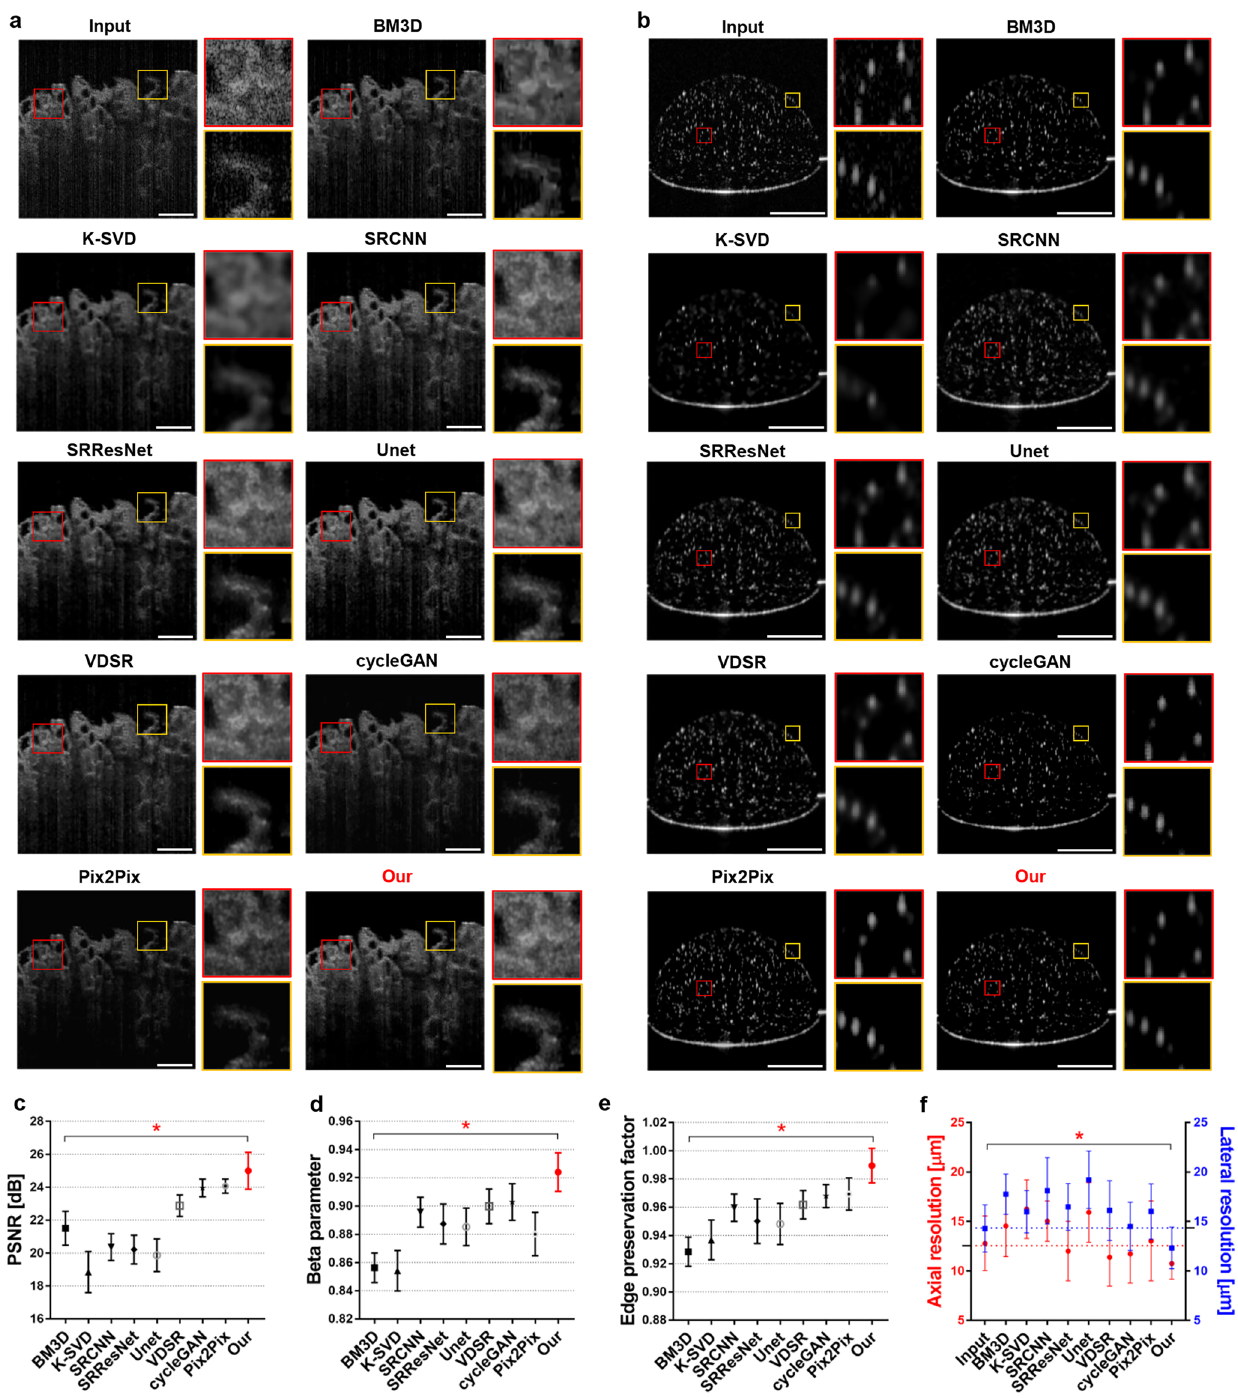
Fig. 5 Results of comparative studies with other methods. Example results for a thyroid tissue specimen and b TiO2 microsphere data. Input, BM3D, K- SVD, SRCNN, SRResNet, Unet, VDSR, cycleGAN, Pix2Pix, and our result are presented in order on both a and b . The input is an image reconstructed by the currently optimized OCT processing. The ROIs (red and yellow boxes) on the right sides of the images show magni fi ed views (3X for a ; 5X for b ) from the same location. Scale bars, 1 mm. Metrics based on thyroid tissue specimen sample for quantitative comparison, c PSNR, d β , and e EPF. Our method showed superiority in terms of SNR and in preserving spatial features. f Axial and lateral resolution measured by microsphere data. Dashed lines represent the axial and lateral resolutions of input. While axial and lateral resolution enhancements were revealed in our method, the quantitative results of other methods were mostly inconspicuous for resolution enhancement. Error bars in c – f represent standard deviations. All of these statistical results were calculated for 200 randomly selected images, and the results of f was estimated from a total of 800 microsphere data. All multiple comparison results for our method were statistically signi fi cant ( P < 0.0001 (*) according to a one-way ANOVA